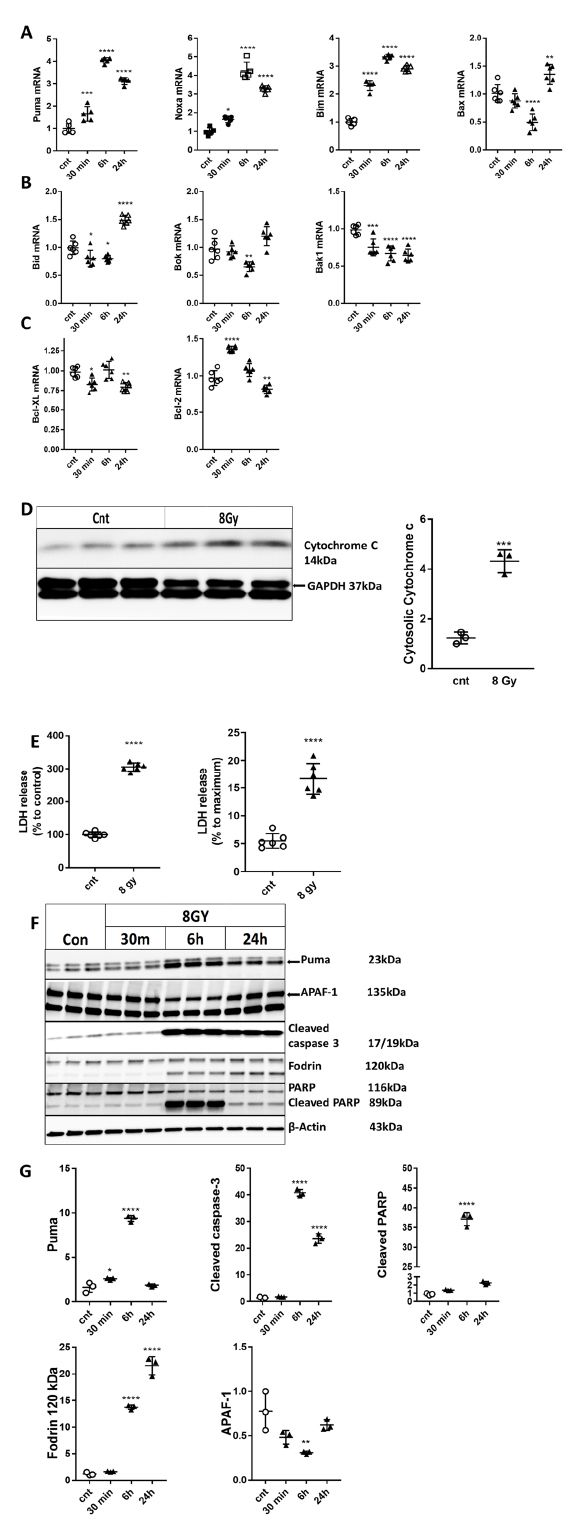
Figure 3. IR up-regulated select pro-apoptotic members of the Bcl-2 family, mitochondrial membrane permeabilization, and release of pro-apoptotic molecules. Neurons were collected at 30 min, 6 h, and 24 h after 8 Gy irradiation. Total RNA was used for qPCR analysis. qPCR quantification of Puma